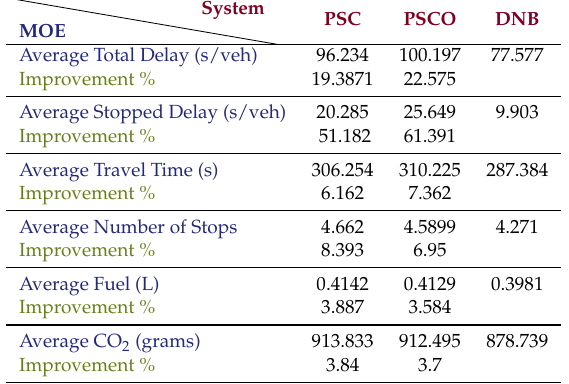
Table 6. Average MOEs and (%) improvement using DNB over the PSC and PSCO